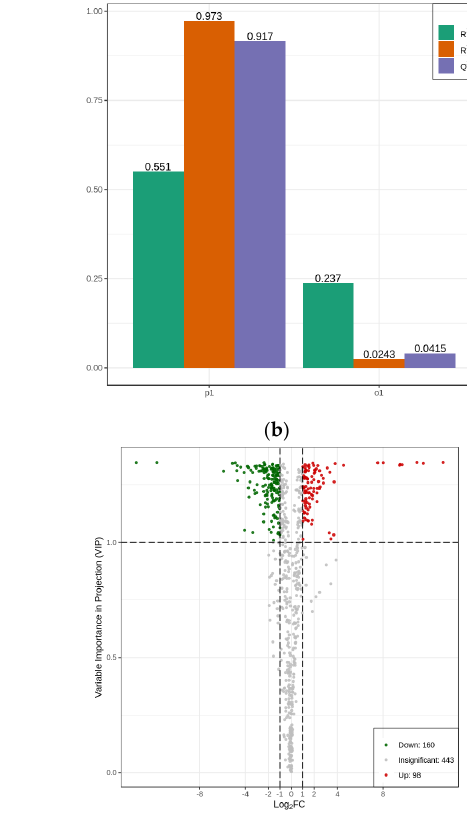
Figure 2. The red color represents the signal of the DIG ‐ labeled female parent (ROC25) DNA probe, and the green color represents the signal of the biotin ‐ labeled male parent (Yunzhe89 ‐ 7) DNA probe (Bar = 6 μ m). ( a ) Zhongzhe 1 sugarcane; ( b ) G160 sugarcane.